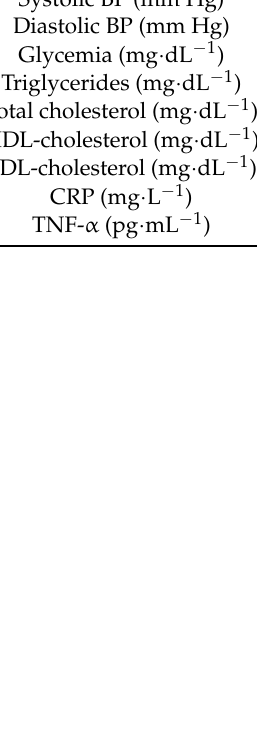
Table 2. Resistance training load progression in the CT